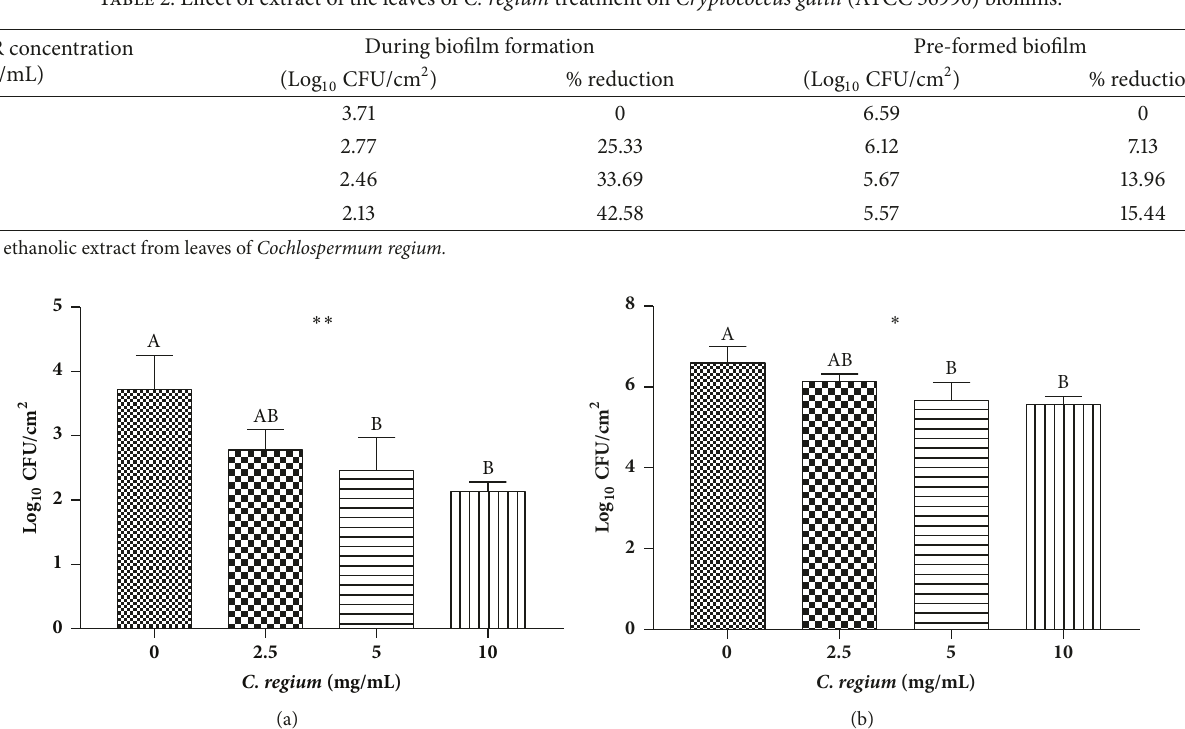
in humans and cause high levels of mortality. Unlike